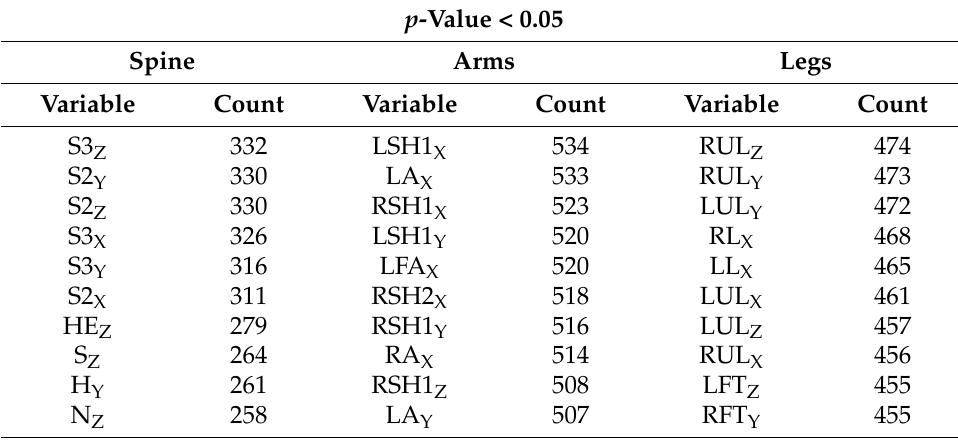
Table 4. G 4 : Motion primitives based on EAWS.